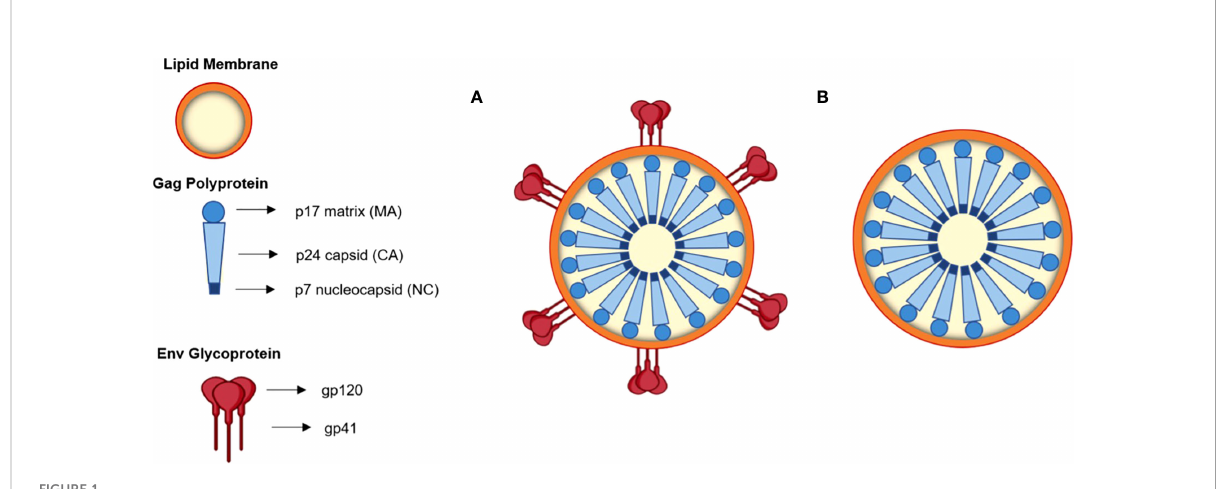
FIGURE 1 Schematic representation of an HIV-1 based VLP (A) and an HIV-1 Gag VLP (B)